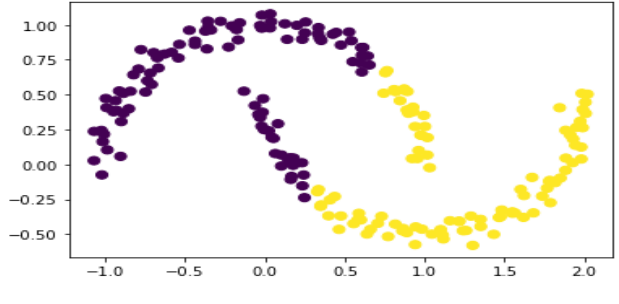
Figure 7. Visualization of